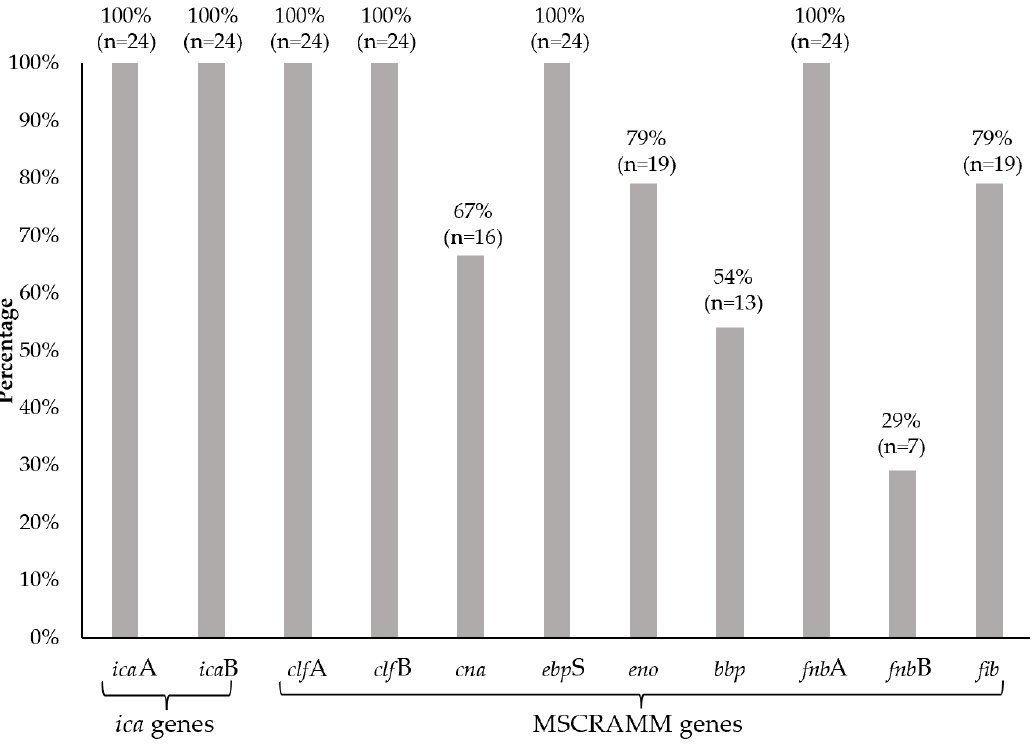
Figure 5. The frequency of occurrence of ica operon genes and genes encoding proteins from the MSCRAMM family in the studied S. aureus strains.